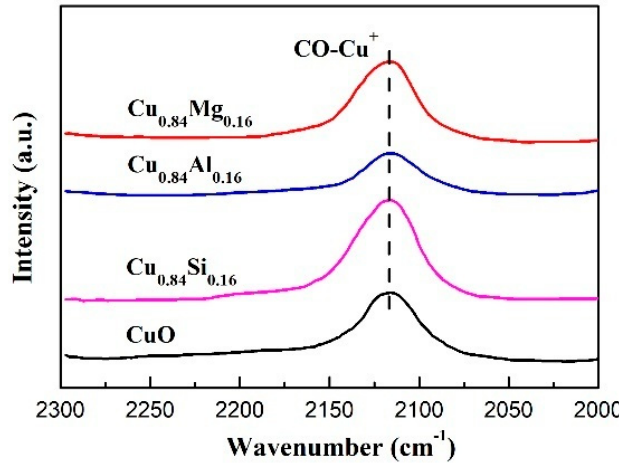
Figure 9. CO-IR spectra of used catalysts.